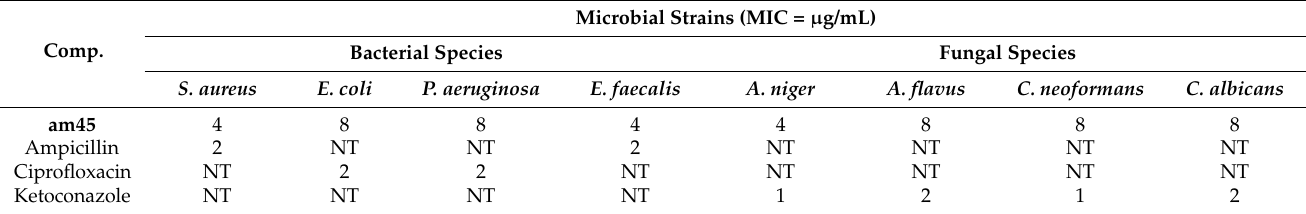
Table 19. Antimicrobial activity (MIC = µ g/mL) of the compound (am45 ).